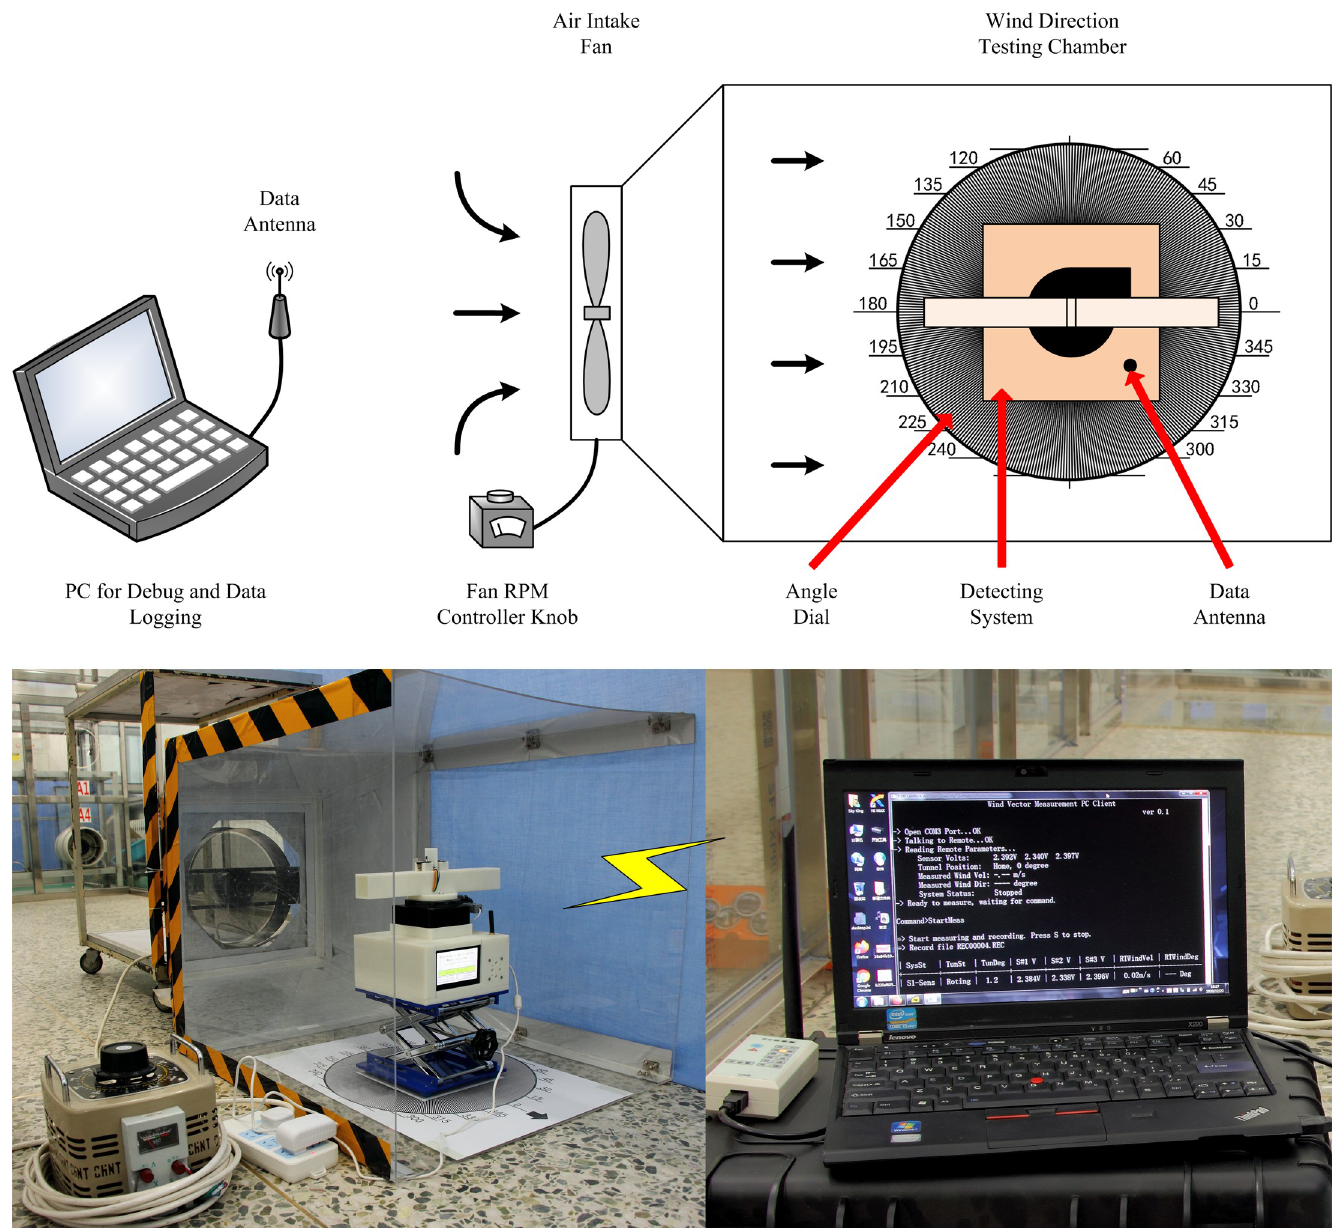
Fig 16. Wind direction test chamber. (A) Block diagram and (B) image of the test chamber.